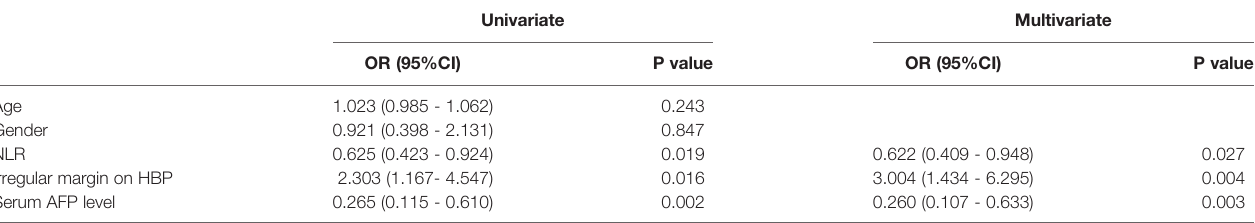
TABLE 2 | Univariate and multivariate assessments of variables associated with VEGF levels in clinical model.